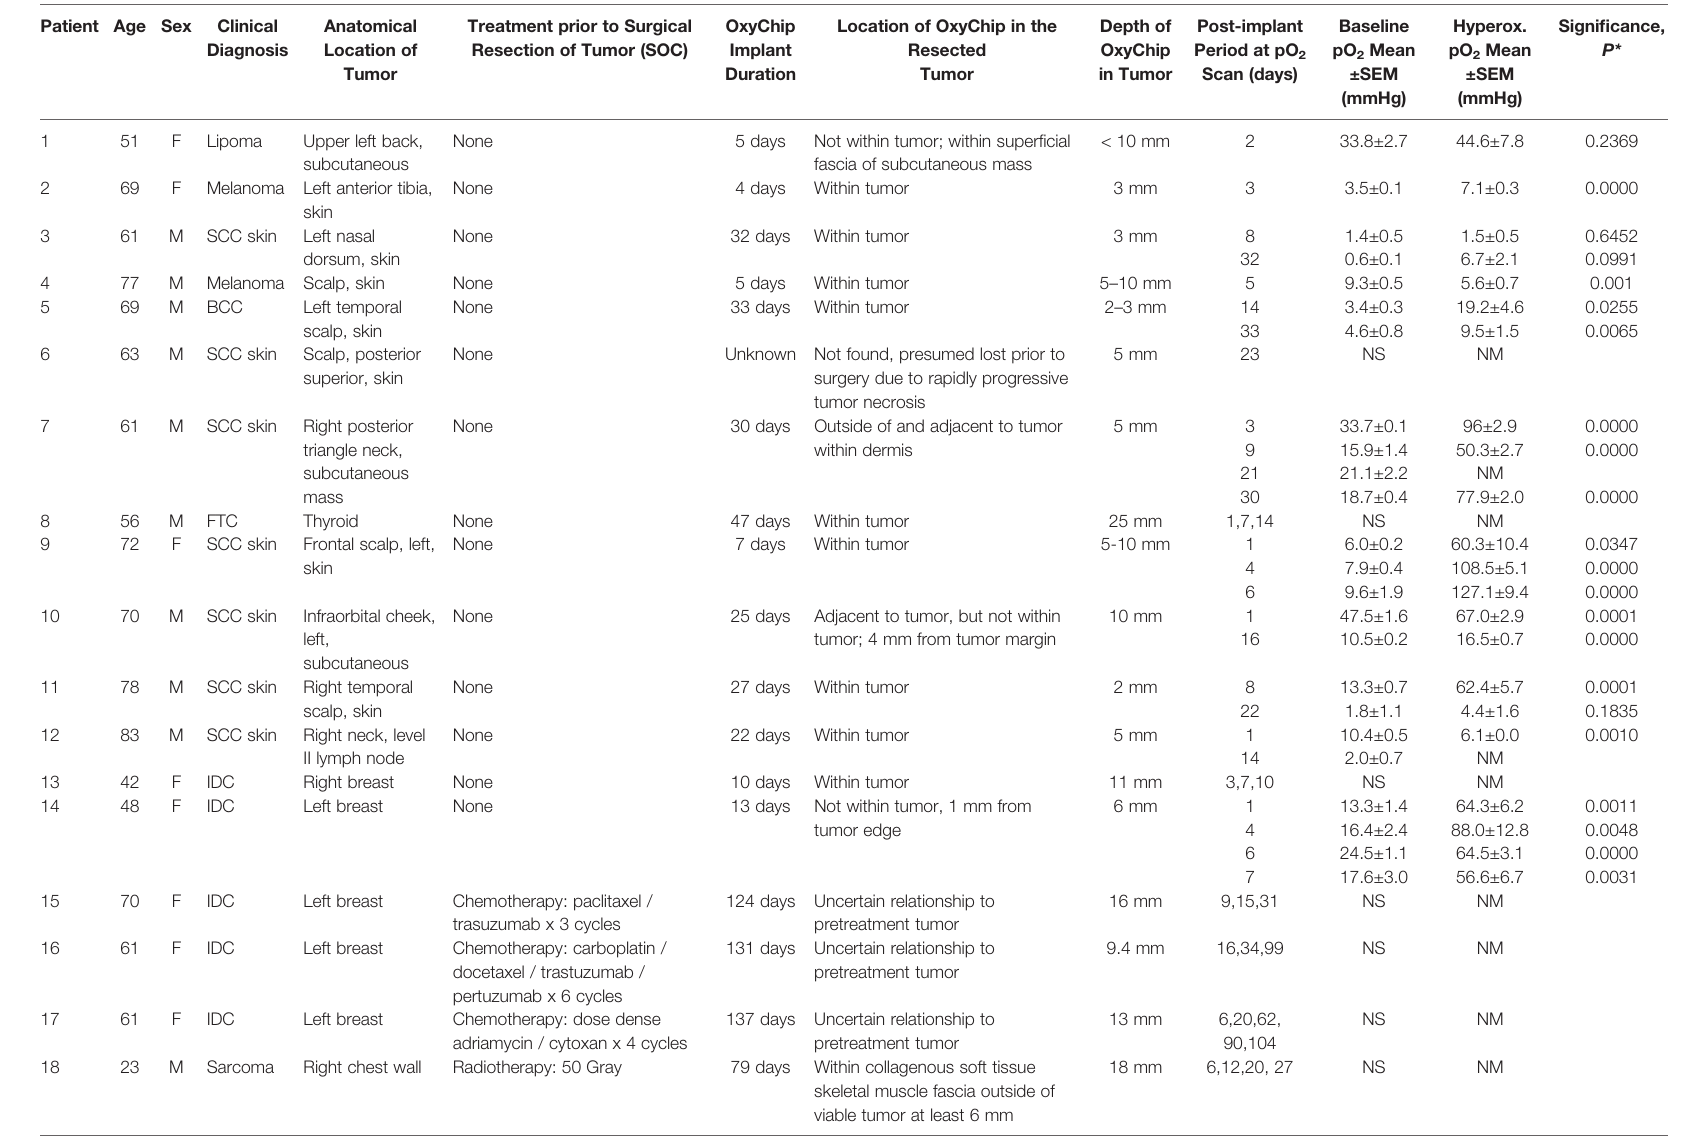
TABLE 1 | Patient information, OxyChip, and oxygen